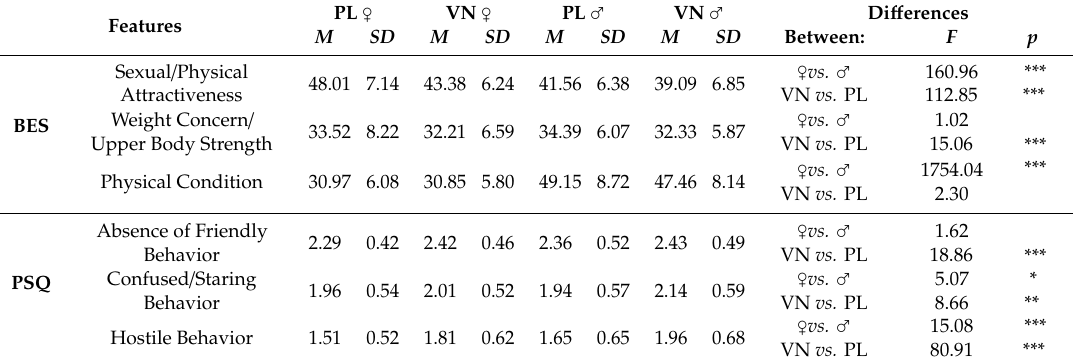
Table 2. Cross-cultural and gender di ff erences of body esteem and perceived stigmatization.